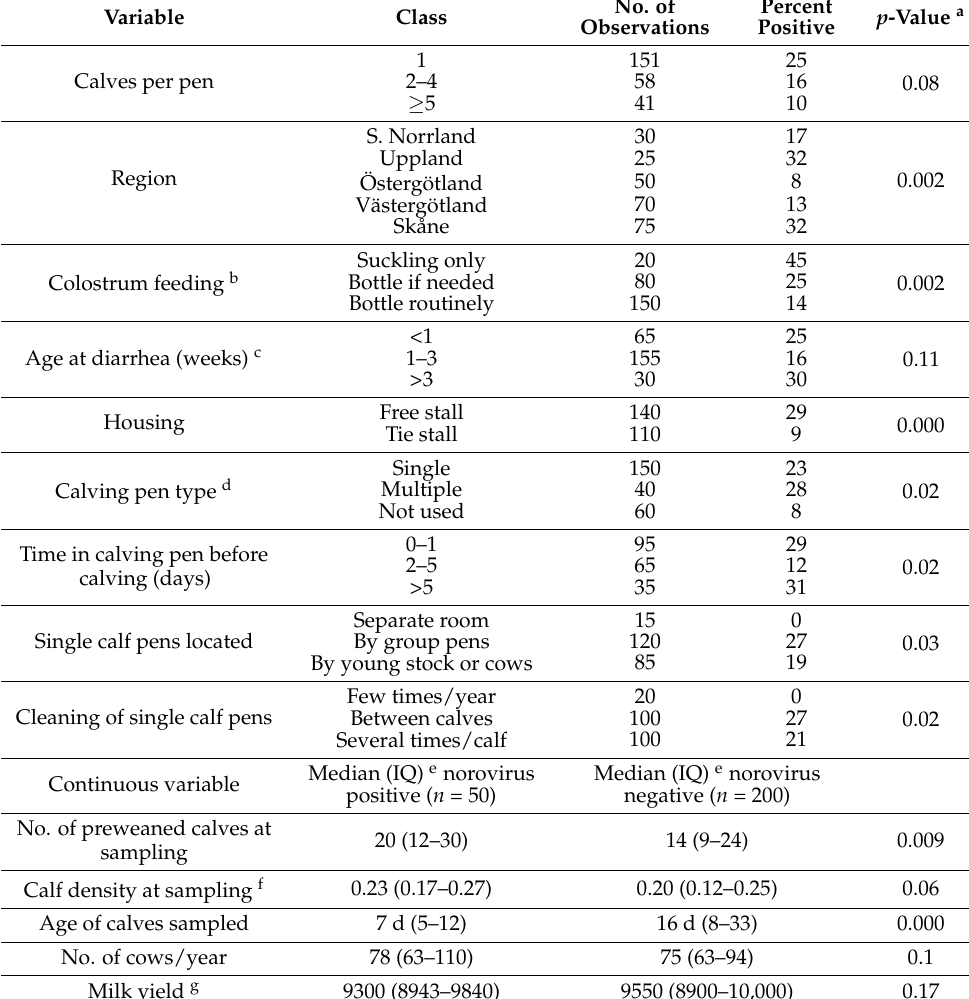
Table 1. Factors univariably associated ( p < 0.2) with bovine norovirus shedding detected by RT-PCR in 250 preweaned calves and offered to the multivariable regression